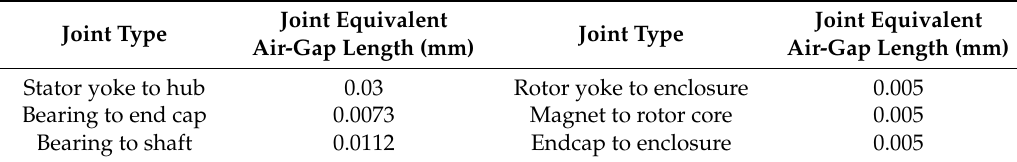
Table 1. Equivalent joint air-gap lengths.